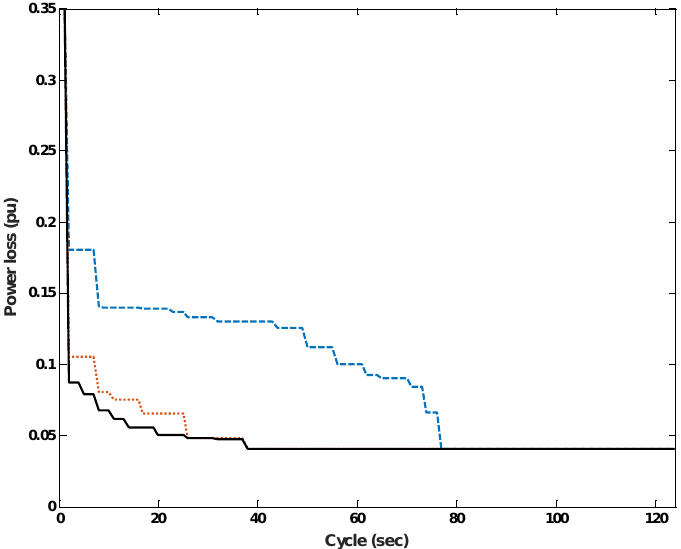
Figure 4. Convergence performance of the proposed algorithm on the IEEE 30 test system.